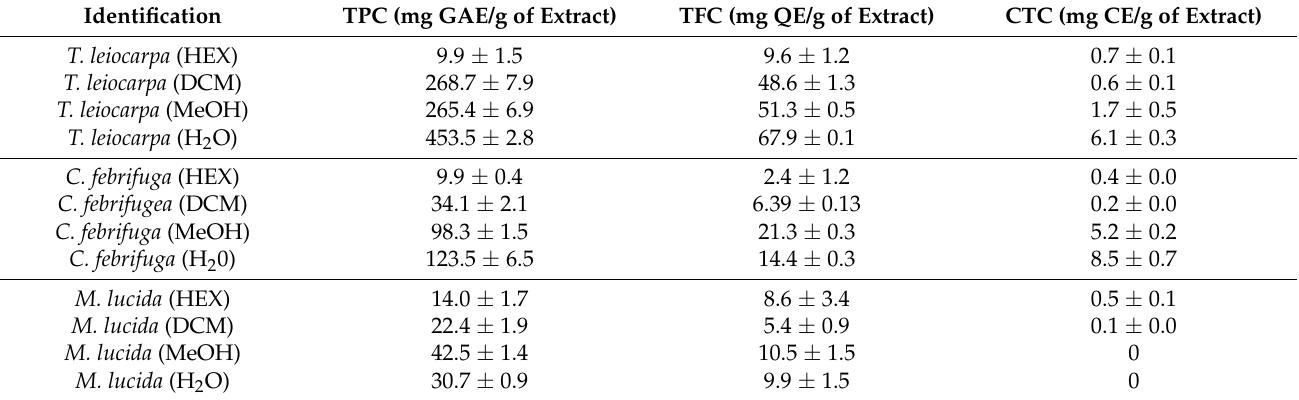
Table 5. Results of the concentration of phenols, flavonoids, and condensed tannins in the selected